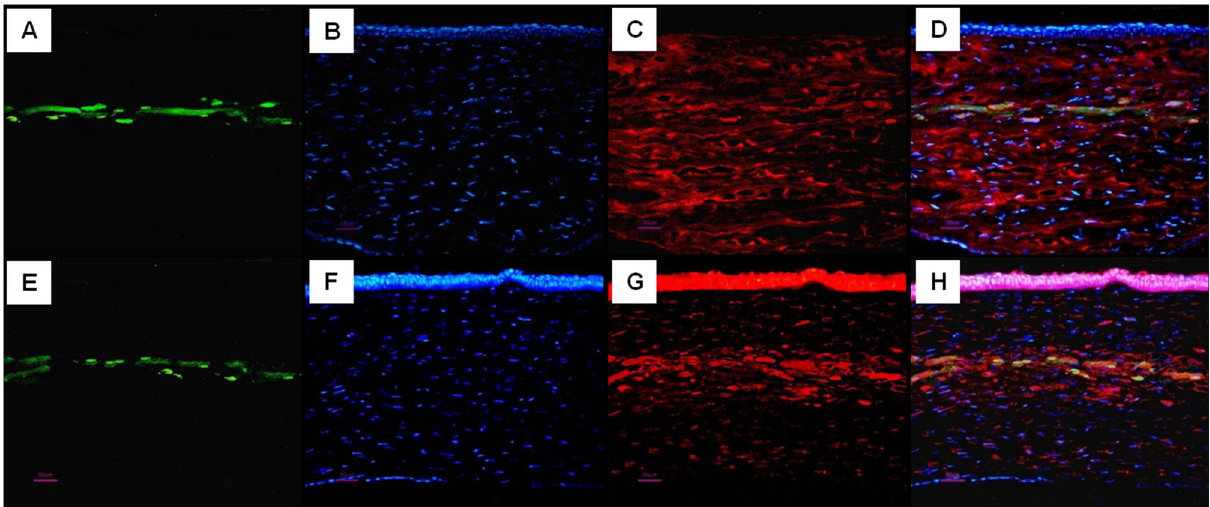
Figure 6. Survival of GFP-positive rASCs after 24 weeks of implantation and their differentiation to functional keratocytes. (A-H) corneas implanted with autologous rASCs-PLGA constructs; (A, E) GFP expression, (green color); (B, F) nuclei staining by hoechst33258 at the same section, (blue color); (C) expression of keratocyte specific proteoglycan keratocan at same section, (red color); (G) expression of ALDH1A1 at same section, (red color); (D, H) GFP expression, nuclei staining and keratocan, ALDH1A1 immunostaining are superimposed with Adobe Photoshop software, showing keratocyte proteoglycan production by implanted GFP-positive rASCs (Bar scales: 50 µm).. doi: